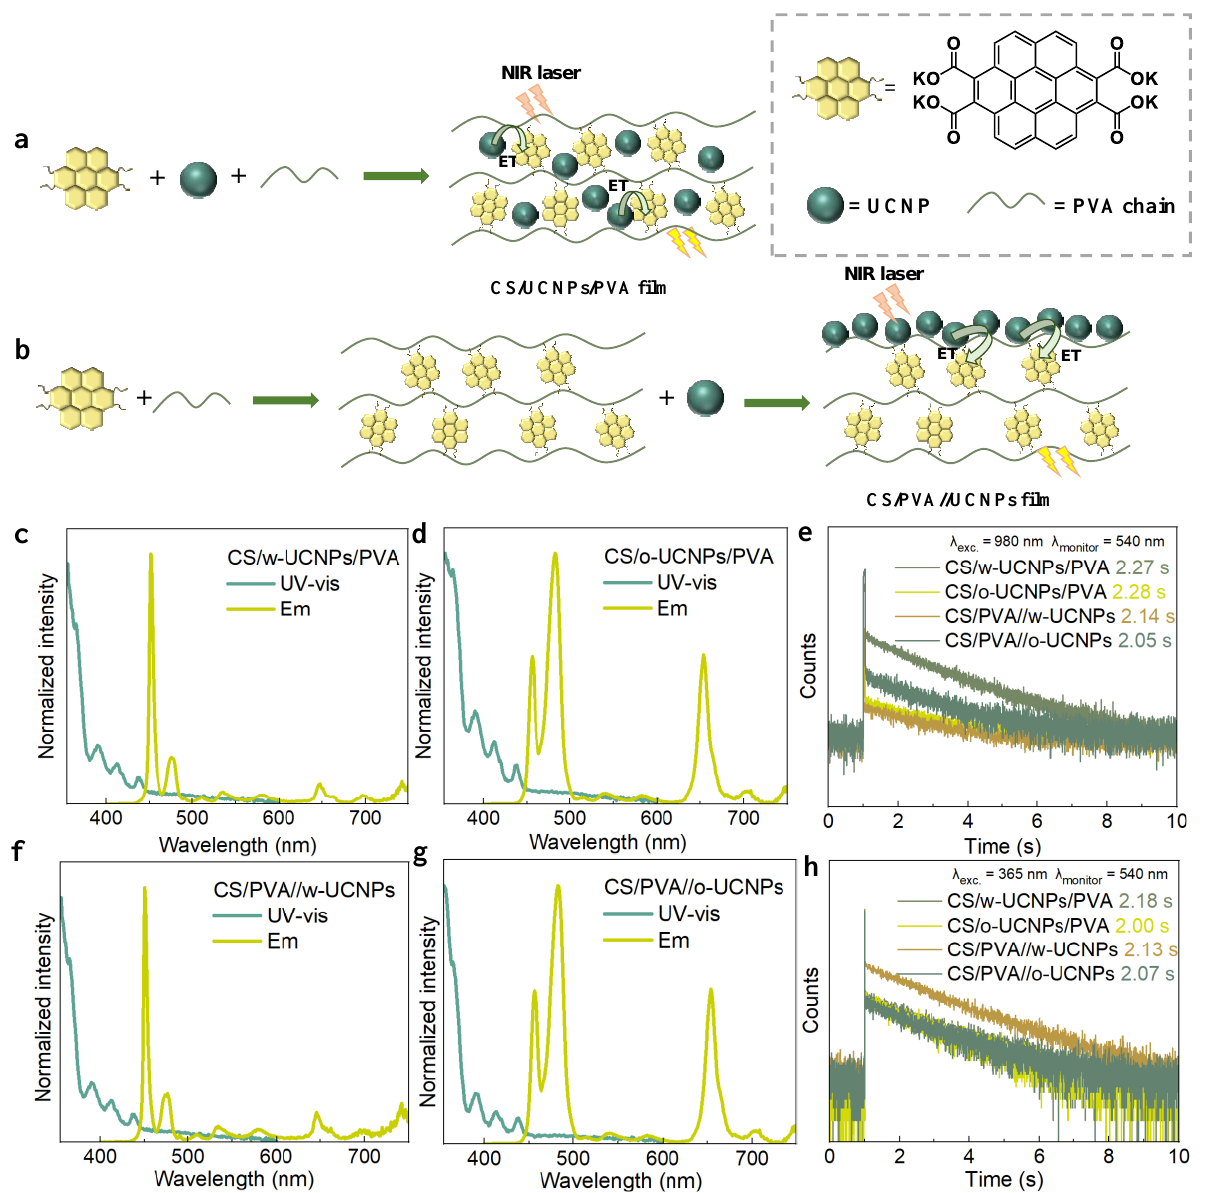
Figure 3. ( a ) Schematic diagram of UCNPs entering CS/PVA hybrid by doping to prepare CS/UCNPs/PVA film; ( b ) schematic diagram of UCNPs entering CS/PVA hybrid by smearing to prepare CS /PVA//UCNPs film; ( c ) normalized UV-Vis spectrum and photoluminescence spectra ( λ exc. = 980 nm) of CS/w-UCNPs/PVA film; ( d ) normalized UV-Vis spectrum and photolumines- cence spectra ( λ exc. = 980 nm) of CS/o-UCNPs/PVA film; ( e ) comparison of lifetime curves of four films under 980 nm excitation; ( f ) normalized UV-Vis spectrum and photoluminescence spectra ( λ exc. = 980 nm) of CS /PVA//w-UCNPs film; ( g ) normalized UV-Vis spectrum and photolumines- cence spectra ( λ exc. = 980 nm) of CS /PVA//o-UCNPs film; ( h ) comparison of lifetime curves of four films under 365 nm excitation. (ET = energy